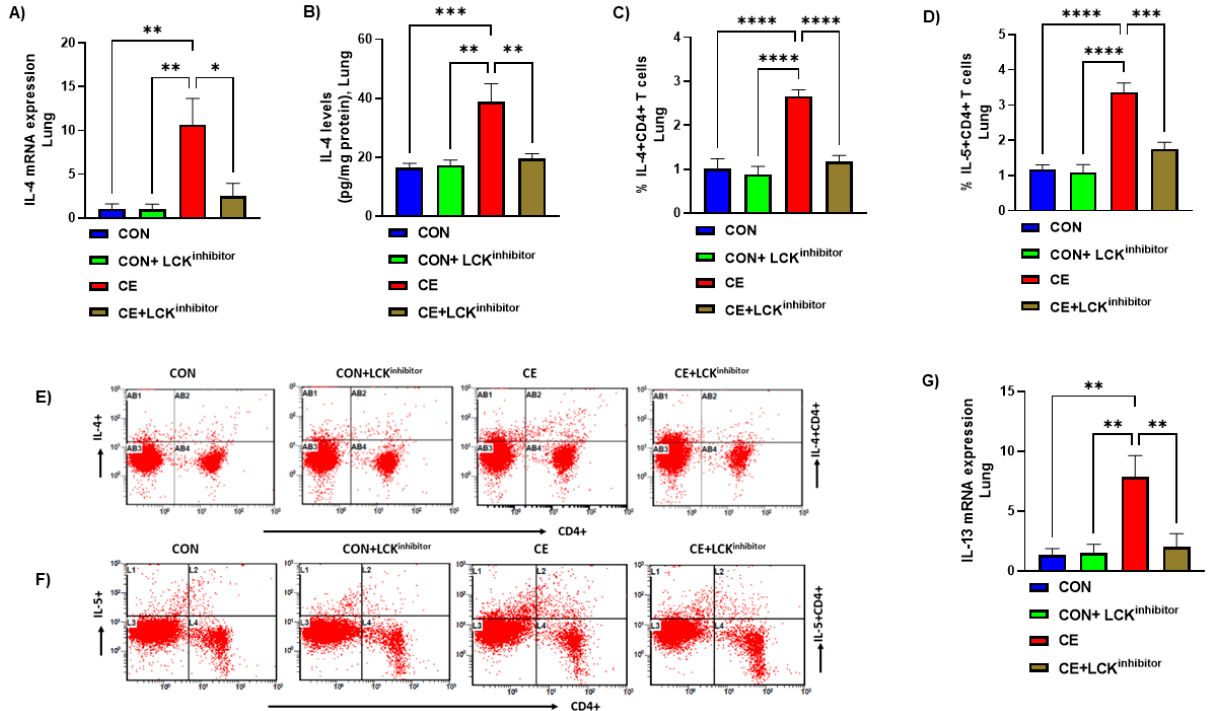
Figure 5. ( A ) IL-4 mRNA expression in lung tissue, ( B ) IL-4 protein levels in the lung tissue, ( C ) % IL-4+CD4+ T cells, ( D ) % IL-5+CD4+ T cells, ( E ) Flow plot with representative depiction of double positive immunostaining in CD4+ T cells, i.e., IL-4+ immunoreactivity in CD4+ T cells, ( F ) Flow plot with representative depiction of double positive immunostaining in CD4+ T cells, i.e., IL-5+ immunoreactivity in CD4+ T cells, and ( G ) IL-13 mRNA expression in lung tissue. Data are presented as mean ± SE, n = 6/group. * p < 0.05; ** p < 0.01; *** p < 0.001; **** p < 0.0001. 3.5. Blockade of LCK Signaling Leads to Augmentation of Treg Cells in CE-Exposed Mice It was also investigated whether LCK signaling blockade affected any modulation of Treg cells in CE-exposed allergic mice. Our data reveal that mice with allergic airway inflammation presented with reduction in Treg immune responses in the pulmonary com-